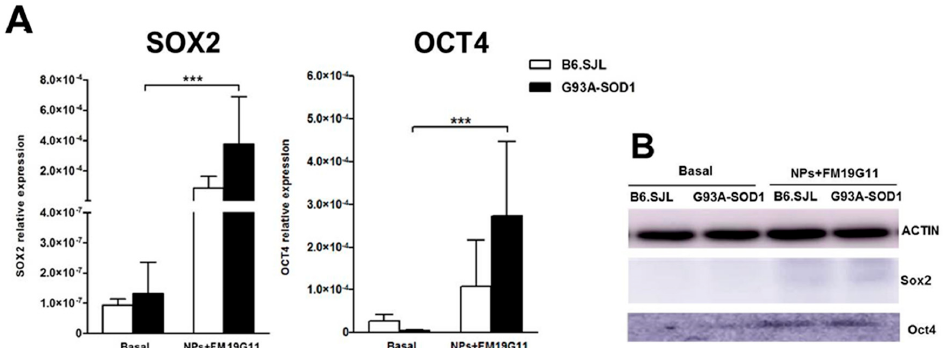
Figure 2. Analyses of SOX2 and OCT4 pluripotency marker expression. ( A ) qRT PCR expression analysis of SOX2 and OCT4 genes in 12-week B6.SJL (white bars) and G93A-SOD1 (black bars) epSPCs after 48 h of FM19G11-loaded NP treatment and under basal conditions. Expression levels reported as mean ± SD of 2 − ∆ CT values normalized against the endogenous control 18S ( n = 5 different primary cell cultures from five animals per group). ( B ) Representative Western blot analysis of SOX2, OCT4, and β -actin ( n = 2 different primary cell cultures from two animals per group). *** p < 0.001 by